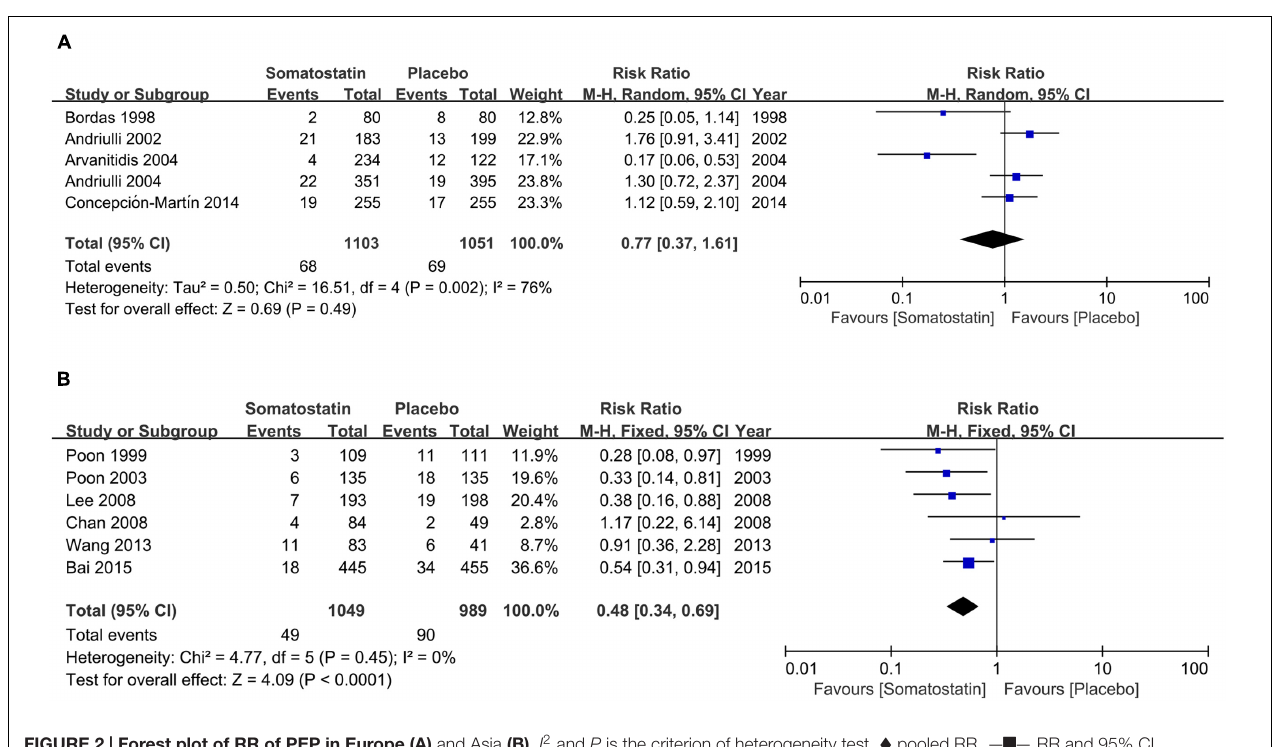
FIGURE 2 | Forest plot of RR of PEP in Europe (A) and Asia (B) . I 2 and P is the criterion of heterogeneity test, (cid:7) pooled RR, — (cid:4) — RR and 95%